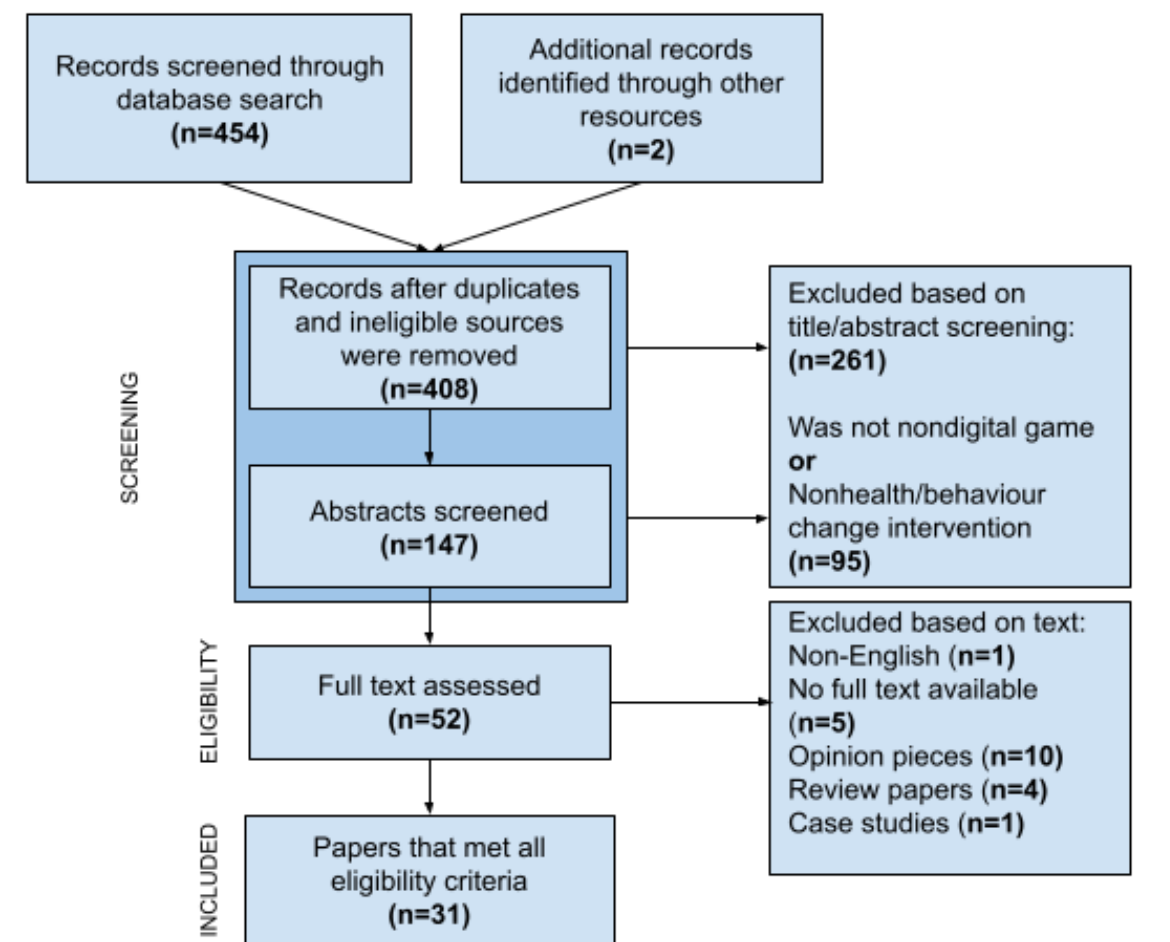
Figure 1. Flow diagram for paper